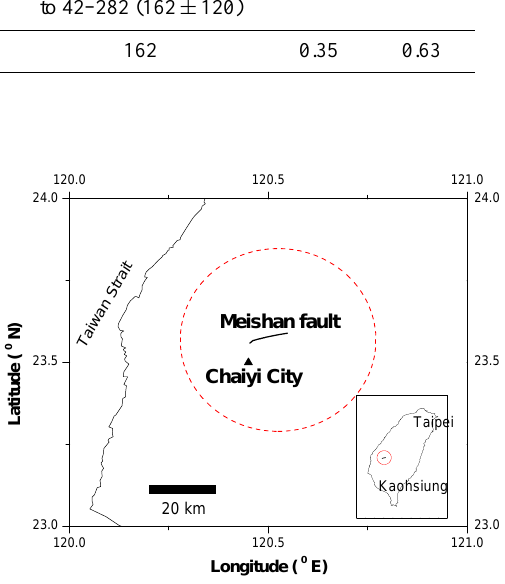
Figure 8. The location of the Meishan fault in central Fig. 8. The location of the Meishan fault in central Taiwan